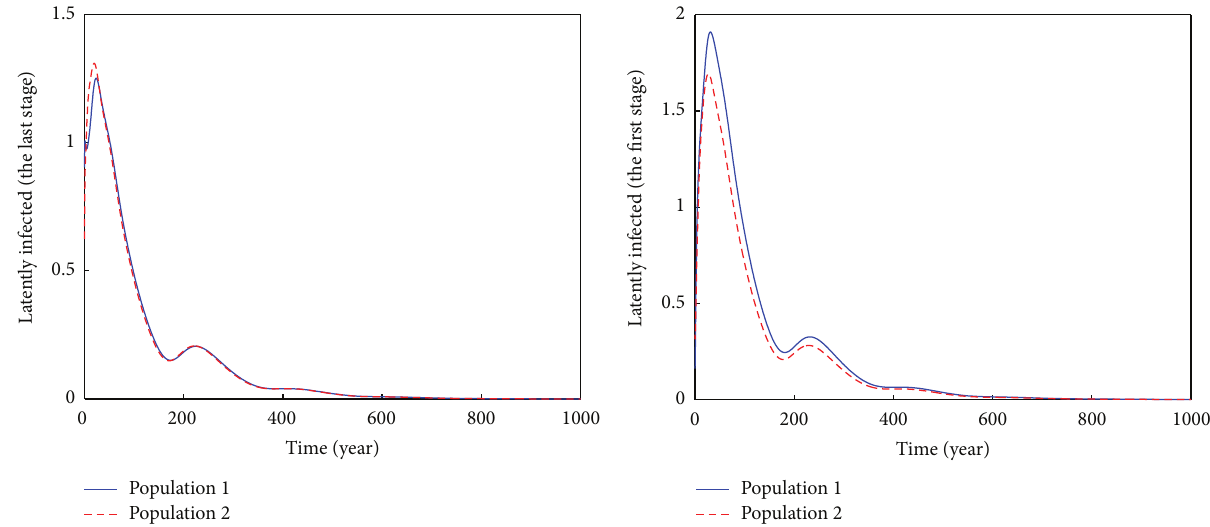
< 1 . All other parameters 0